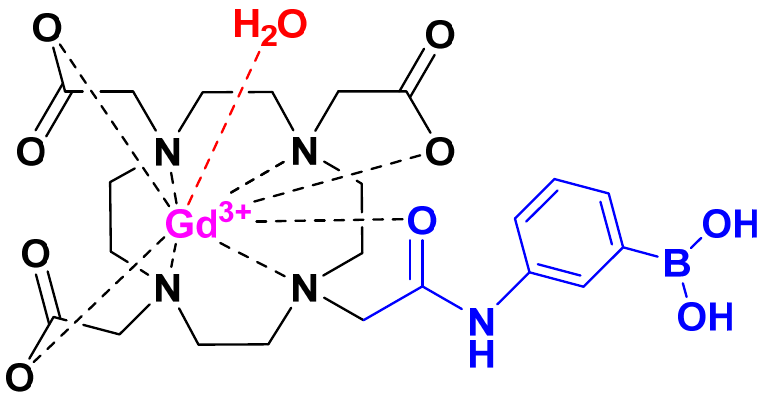
Figure 1. Molecular structure of Gd-DO3A-Am-PBA.